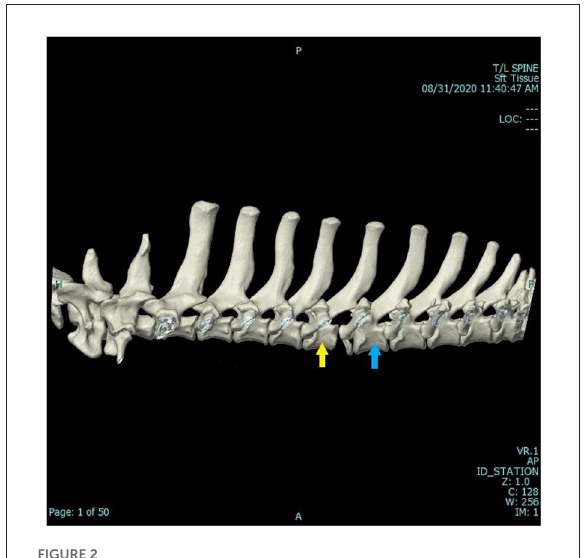
FIGURE2 CT 3-D reconstruction of the patient’s spine while traction was applied. The patient was in dorsal recumbency in the gantry of the CT. The forelimbs were held in extension and secured to the movable table. Traction, approximately enough to lift the patient (20kg), was applied to the pelvic limbs which were then secured to the table thereby maintaining traction. The yellow arrow indicates T5, and the blue arrow indicates T6. This image was take preoperatively, and the patient was under general